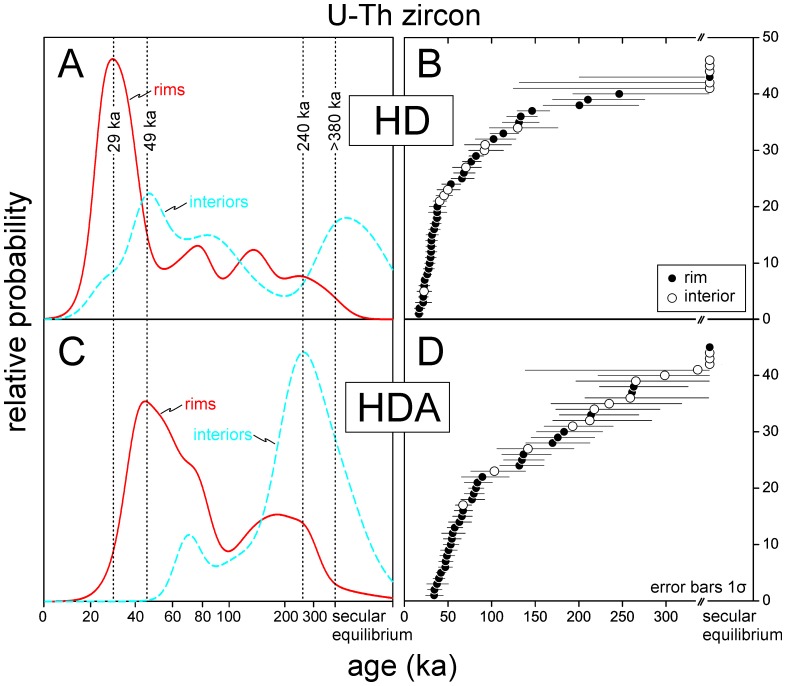
Relative probability and ranked order plots of U-Th zircon rim and interior crystallization ages for Hasan Dağı.Peak zircon crystallization ages for sample HD range between ∼29 ka and secular equilibrium (A, B). Peak zircon crystallization ages for HDA are between ∼49 ka and 240 ka, with some secular equilibrium ages present, mostly for crystal interiors (C, D). Error bars are plotted at 1σ for clarity.